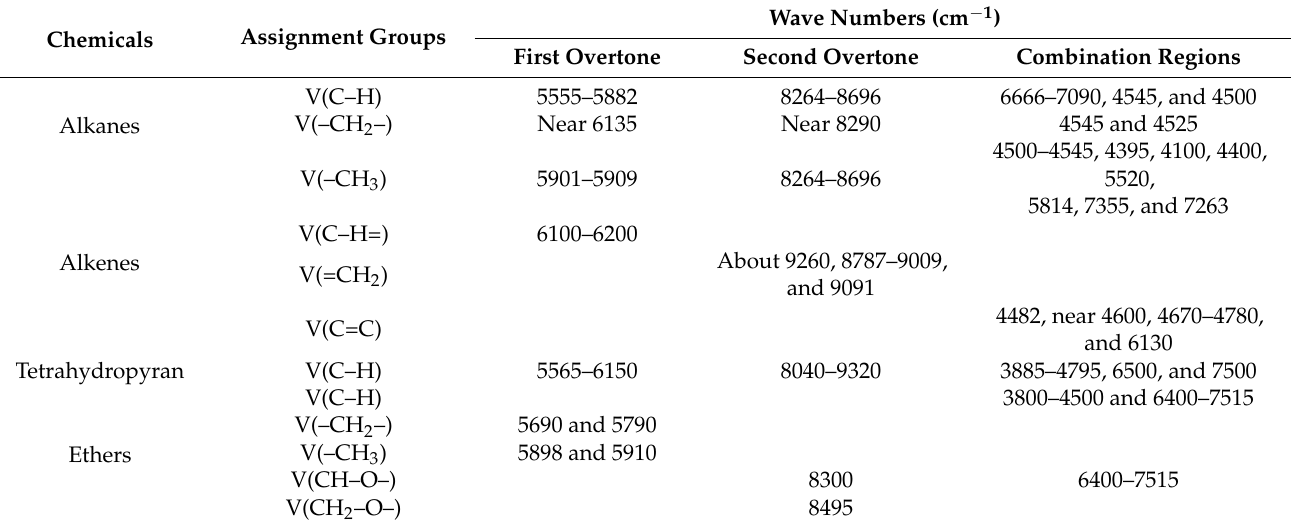
Table 3. Spectral mapping analysis of functional groups in similar substances of Rose Oxide .